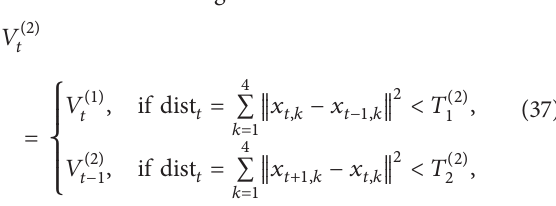
of continuous characteristic pixels and the Bhattacharyya coefficient for 𝐴 are both higher, the initial rectangular tracking area for 𝐵 will refer to 𝐴 ’s settings, and the tracking area will be determined by the previous frame mean